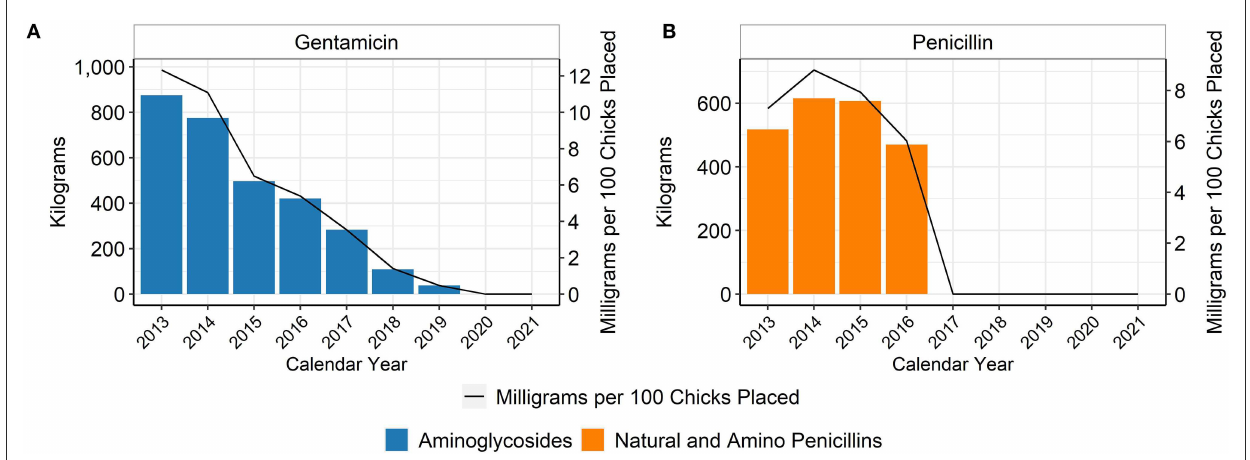
FIGURE1 Gentamicin (A) and penicillin (B) used in broiler hatcheries, 2013–2021. Total kilograms are shown by the bars (left Y-axis) and total mg/100 birds placed are shown by the line (right Y-axis).